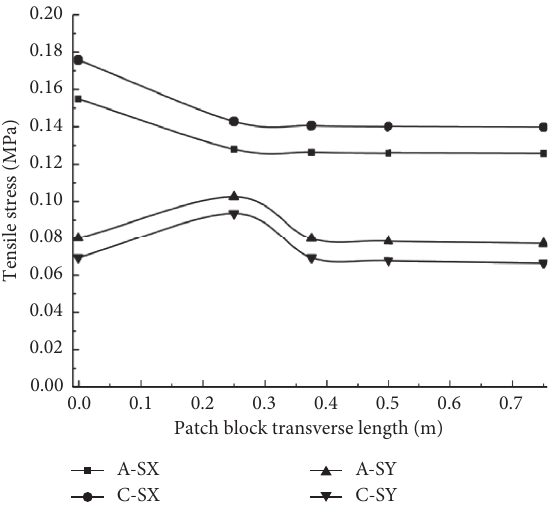
Figure 6: The effects of lateral movement of different loading positions on tensile stress of joint filling material.